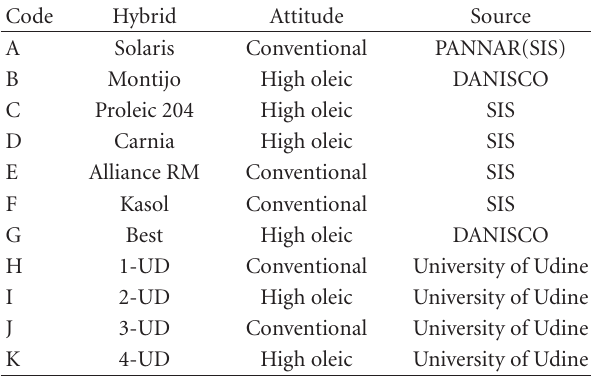
Table 1: List of commercial and experimental sunflower hybrids tested in anticipated sowing dates in 2007-08 and 2008-09 at Valenzano and Foggia (Southern Italy), specified for productive attitude and source.